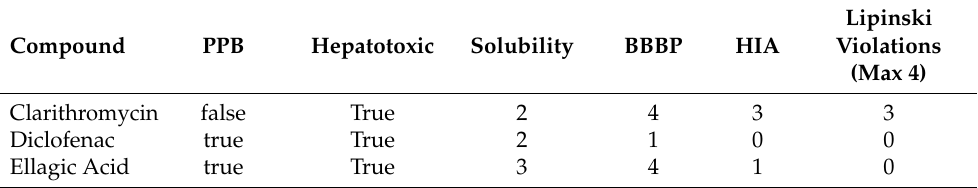
Table 4. ADME prediction of controls and Ellagic